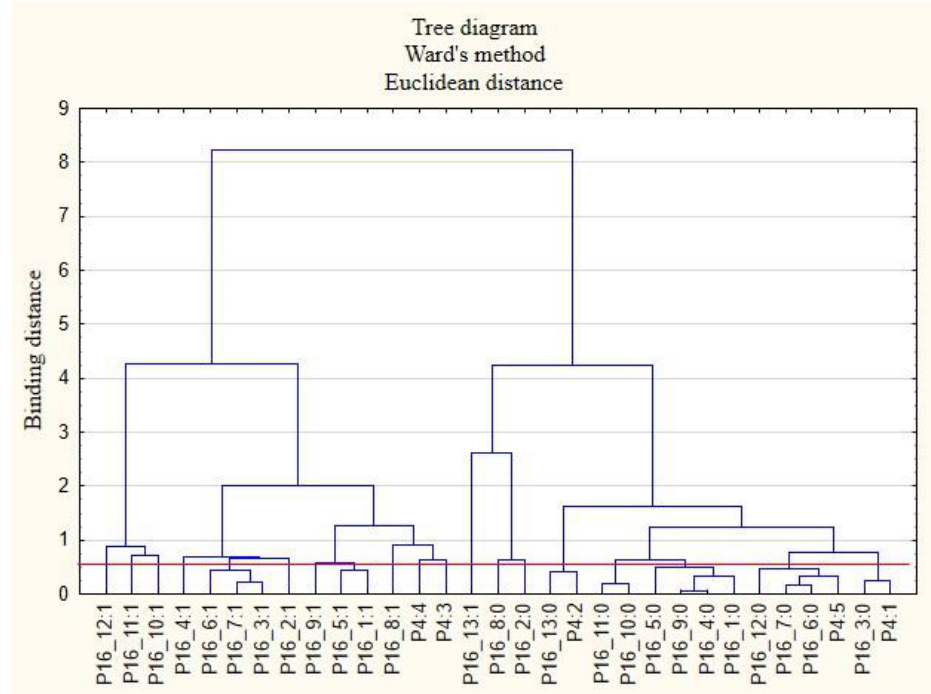
Int. J. Environ. Res. Public Health 2022 , 19 , x FOR PEER REVIEW 15 of 21 Figure 9. Diagram of hierarchical classification of variable categories: support that respondents want to receive after the end of the COVID-19 pandemic from the employer in the area of healthcare and the effective use of the benefits offered (P16) as well as the amount of employment in the company (P4).